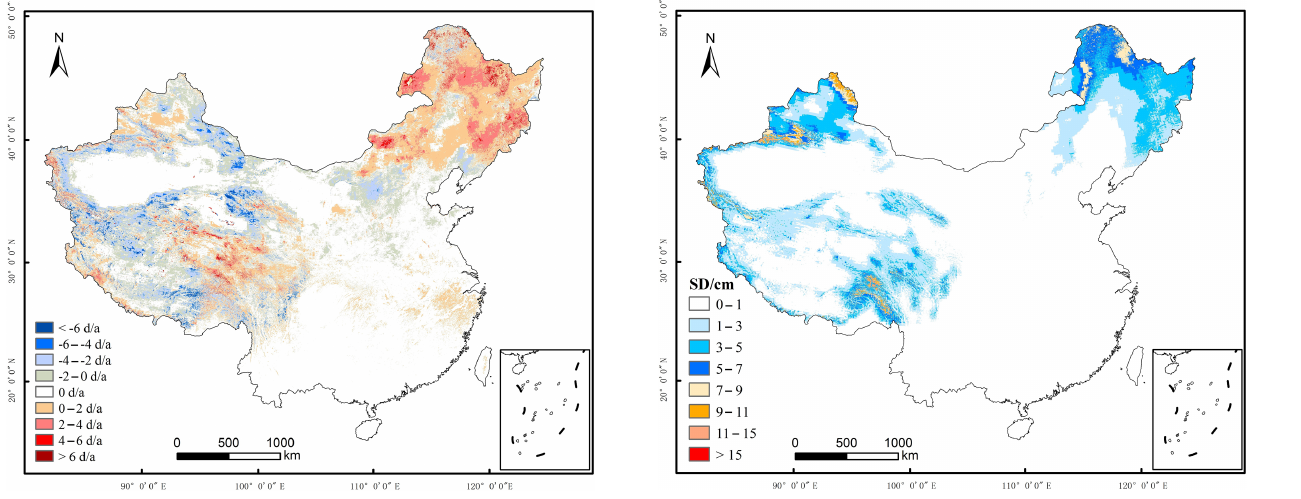
Figure 7. Variation slope of the average annual number of SCD in China based on Sen’s median method during the period of 2001– 2014.